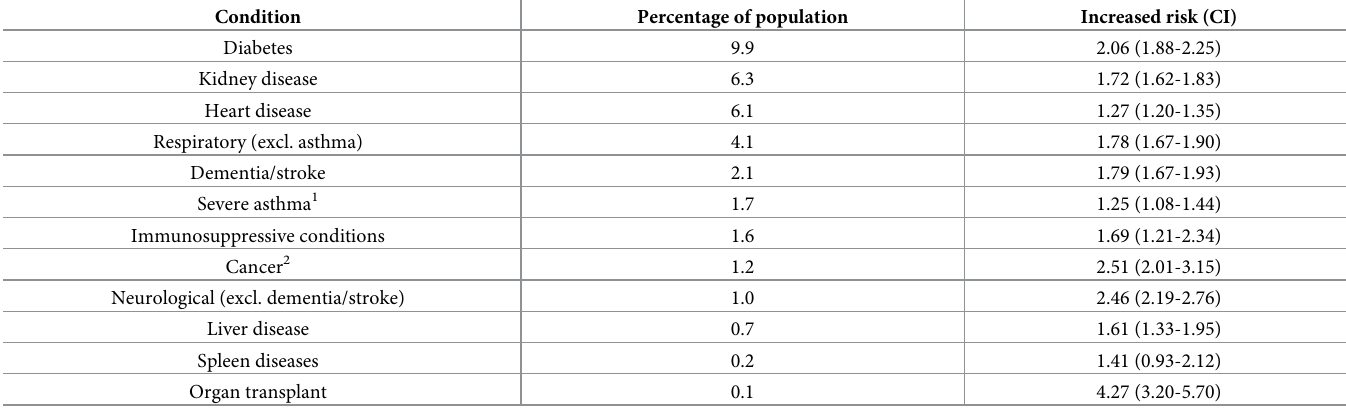
Table 1. Table of identified significant health conditions as calculated in [32]. For each condition we give the estimated prevalence in the population as well as the increased risk of death found as a hazard ratio calculation adjusted for demographics and coexisting conditions.